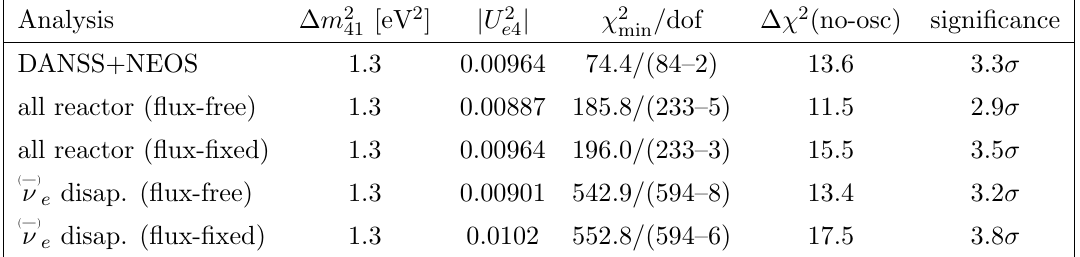
{ ) Table 2 . Results on ( (cid:23) e disappearance from DANSS+NEOS, from a (cid:12)t to all reactor data (both { ) for free (cid:13)uxes and (cid:12)xed (cid:13)uxes), and from a (cid:12)t to the combined ( (cid:23) e disappearance data listed in table 1. For each combination of data sets, we give the parameter values and the (cid:31) 2 value per degree of freedom at the best (cid:12)t point. In all (cid:12)ts, we treat (cid:18) 14 and (cid:1) m 2 as free parameters. For 41 { ) the \all reactor" sample, we also leave (cid:18) 13 free. In the \ ( (cid:23) e disap." analyses, all parameters listed in eq. (3.2) are allowed to (cid:13)oat. For the analyses with free reactor (cid:13)uxes, there are two additional free parameters corresponding to the normalization of the 235 U and 239 Pu (cid:13)uxes. The last two columns of the table give the (cid:1) (cid:31) 2 between the no-oscillation hypothesis and the best (cid:12)t, as well as the signi(cid:12)cance at which the no-oscillation hypothesis is disfavoured. It is obtained by assuming